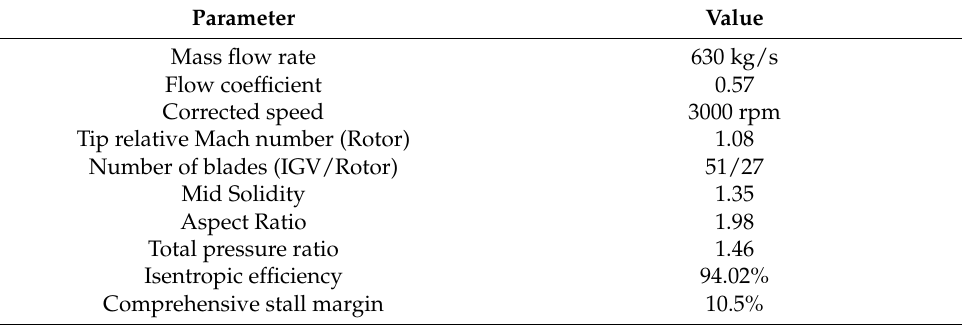
Table 1. Specification of the original rotor design.